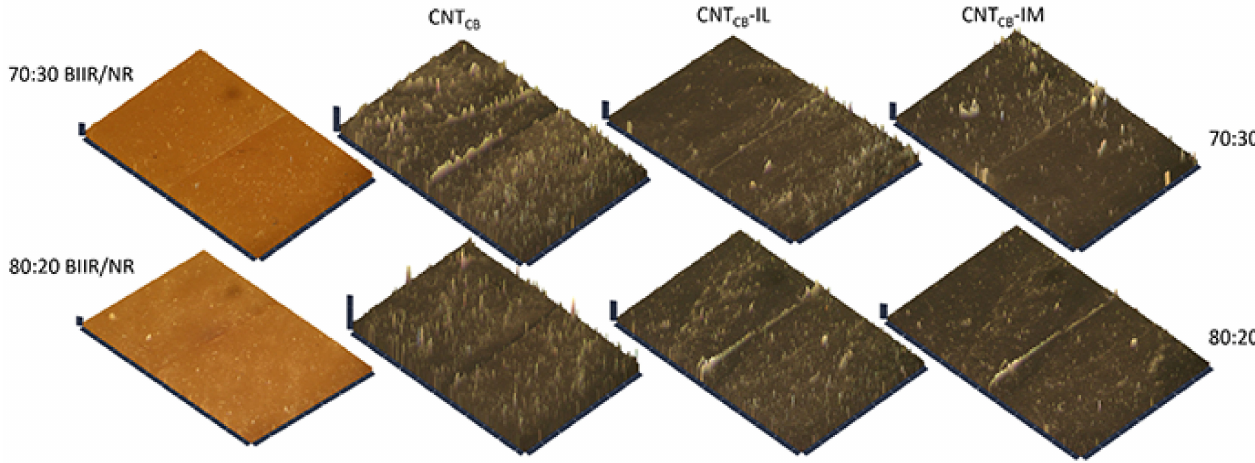
Figure 11. Morphologies of pure rubbers and their composites with and without IL and IM modifiers, BIIR:NR ratios of 70:30 and 80:20 after healing